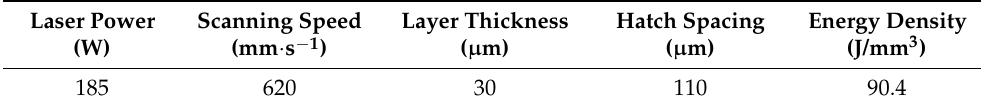
Table 2. SLM processing parameters used to produce the specimens. Laser Power Scanning Speed Layer Thickness Hatch Spacing Energy Density (W) (mm · s − 1 ) ( µ m) ( µ m) (J/mm 3 ) 185 620 30 110 90.4